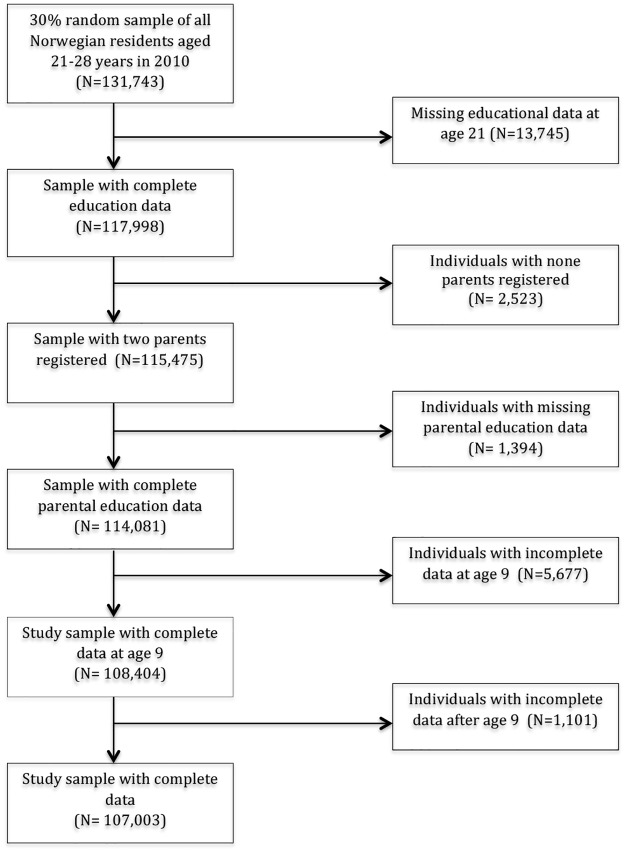
Flow chart of the participants in the present study who were included in the analyses.